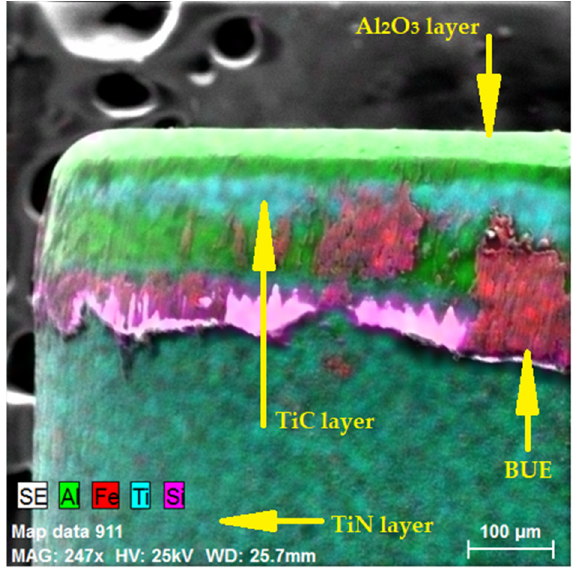
Figure 8. EDX analysis of wear range of CNMG 120408-PM 4315.